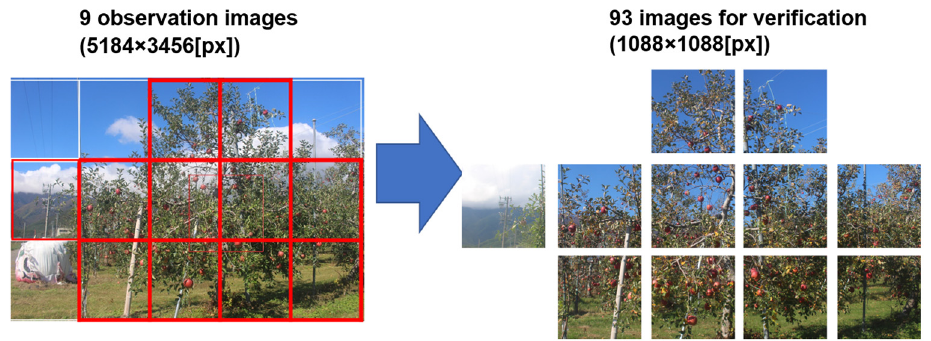
Figure 6. Generation of images for verification from observed images. Nine images (5184 × 3456 Generation of images for verification from observed images. Nine [px]), one for each day, were selected from the period 11 September to 20 November 2018, as images for validation data. Since the proposed model requires 1088 × 1088 [px] images as input data, each original image that is 5184 × 3456 [px] was cut and separated into 11 sections, generating 99 images with a resolution of 1088 × 1088 [px]. The 93 images were used as validation images because 6 of the images had no fruit.